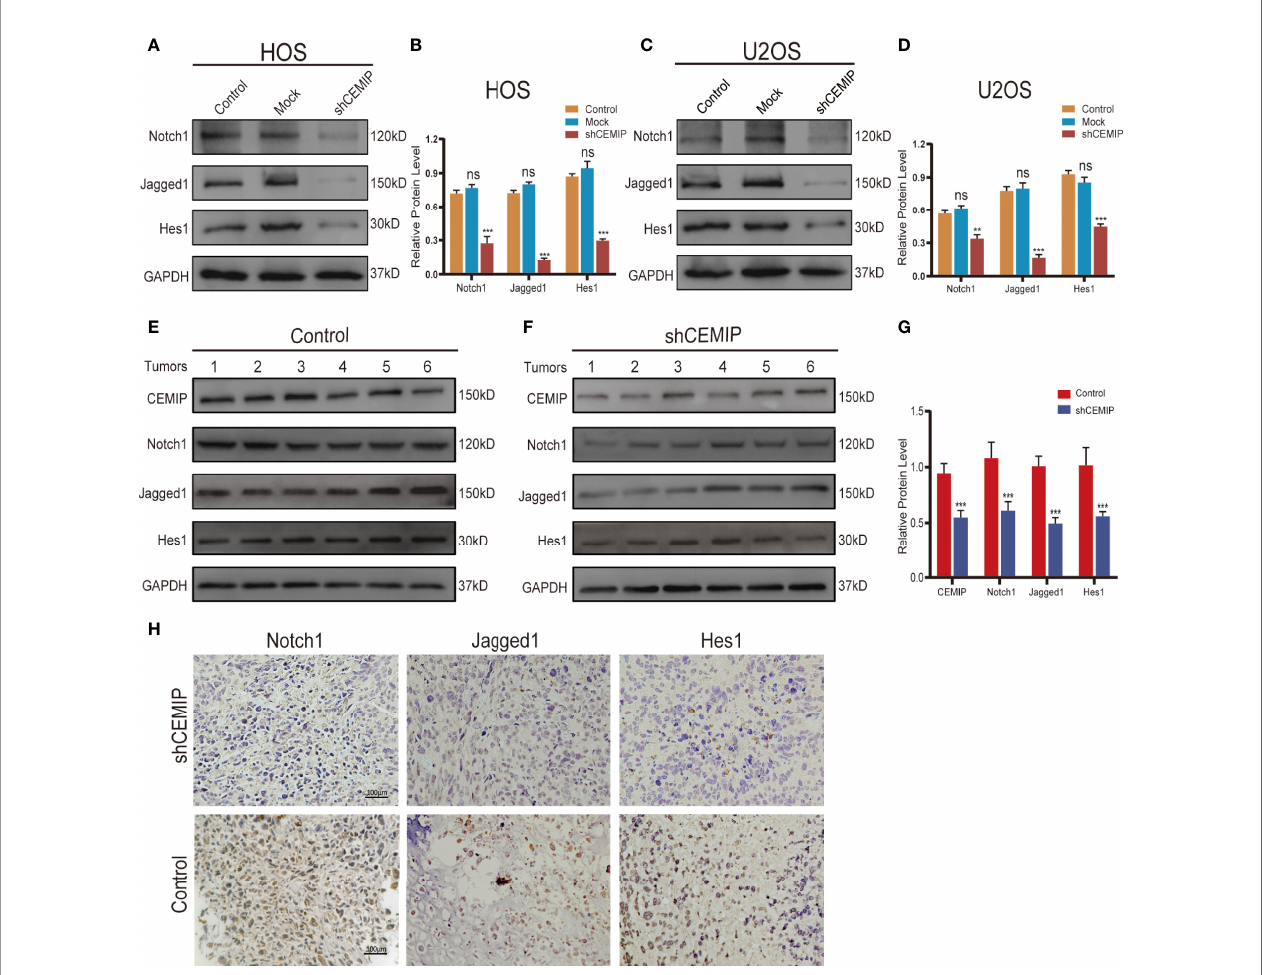
FIGURE 6 | CEMIP promotes the growth and metastasis through Notch signaling pathway. (A, B) Western blot and their quantitative analysis of silencing CEMIP on expression of Notch1, Jagged1 and Hes1 in HOS cells. (C, D) Western blot and their quantitative analysis of silencing CEMIP on expression of Notch1, Jagged1 and Hes1 in U2OS cells. (E – G) Western blot and their quantitative analysis of CEMIP, Notch1, Jagged1 and Hes1 in tumor tissues from two groups of xenograft tumors. (H) Immunohistochemical analysis of Notch1, Jagged1 and Hes1 in osteosarcoma tissue from two groups of xenograft tumors. **P < 0.01, ***P < 0.001. ns, no signi fi